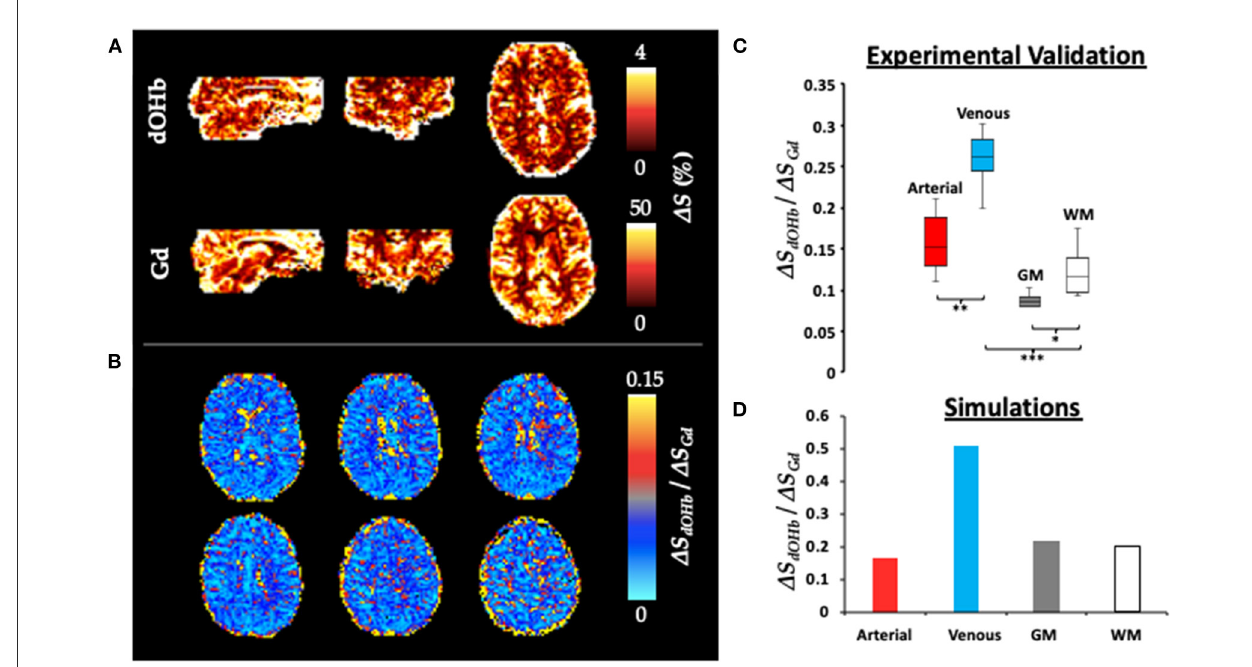
FIGURE4 1 S for Gd and dOHb in Artery, Vein, GM, and WM. (A) 1 S (%) maps (representing 1 S max ) for Gd and dOHb in a representative subject. Note that the dOHb map here is an average of the following paradigms: small 1 S a O 2 with high base-S a O 2 , medium 1 S a O 2 with high base-S a O 2 , large 1 S a O 2 with high base-S a O 2 . (B) Six representative axial slices of 1 S dOHb map divided by 1 S Gd map. (C) Box and whisker plot (average from all subjects) of 1 S dOHb / 1 S Gd for various tissue compartments, including artery (red), vein (blue), GM (gray), and WM (white). Significant differences are denoted with asterisks. (D) 1 S dOHb / 1 S Gd for simulated artery (red), vein (blue), GM (gray), and WM (white) voxels. Simulated dOHb bolus followed a 98–84% S a O 2 profile. Simulated Gd bolus has a peak concentration of 6mM. Simulated CBV values were as follows: artery (90%), vein (90%), GM (4%), and WM (2%).